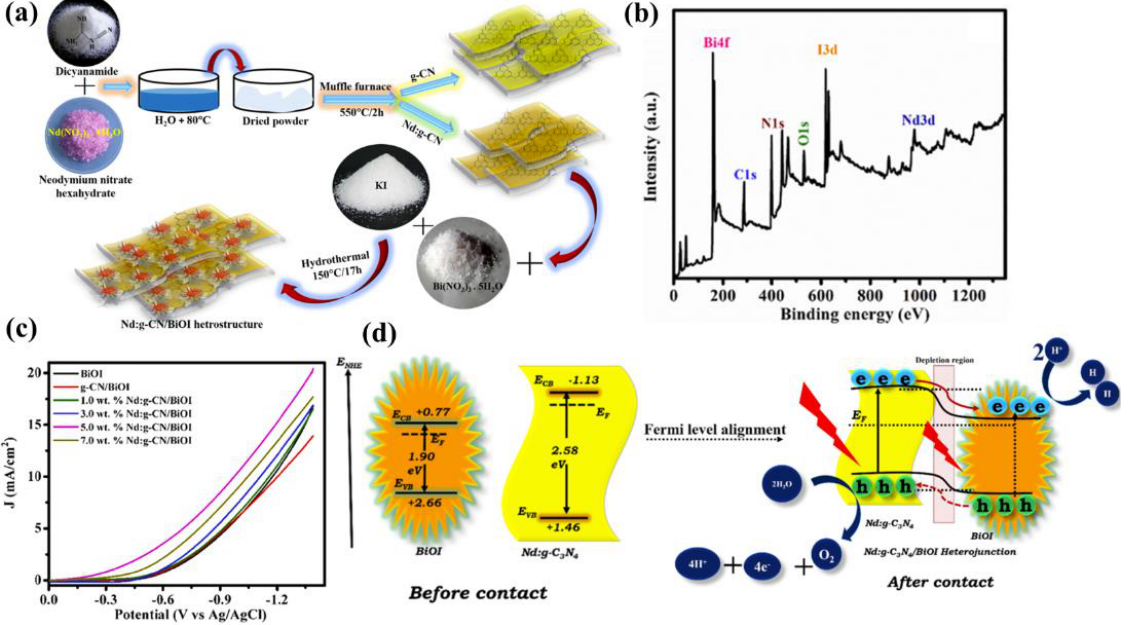
Figure 23. ( a ) Schematic diagram ( b ) wide scan spectrum of XPS spectra of Nd-doped g−CN /BiOI ( c ) photocurrent density versus potential curves (LSV) under light conditions. ( d ) Schematic diagram of PEC mechanism. Reprinted with permission from ref. [230] Copyright 2021Elsevier.